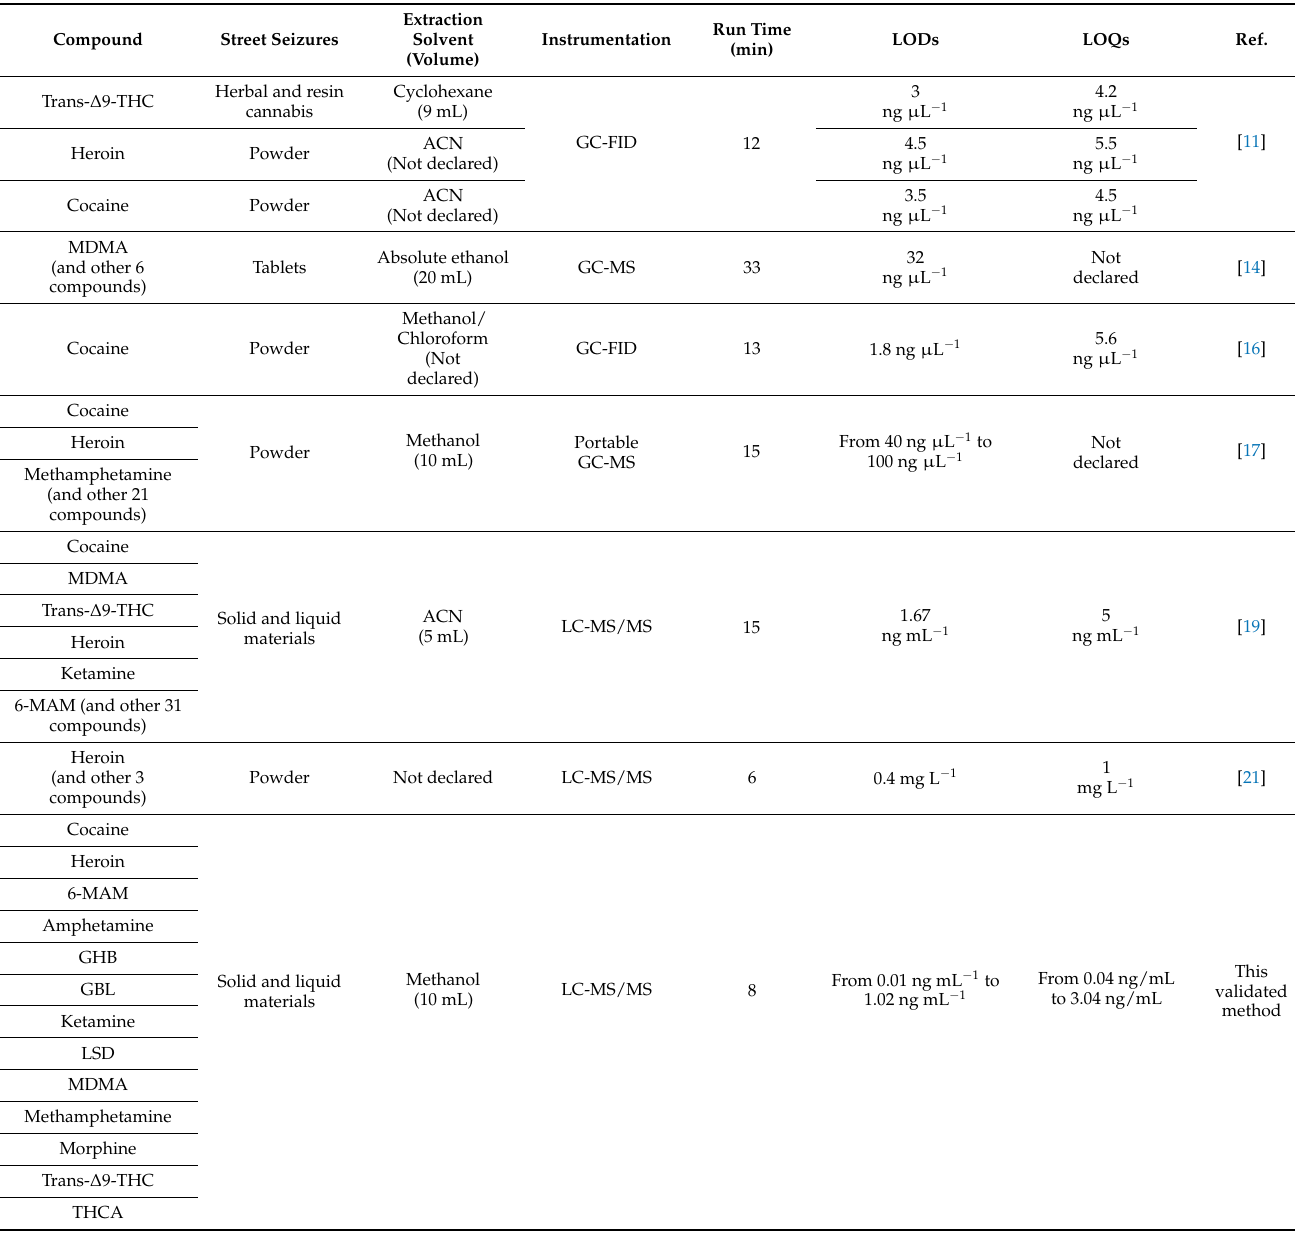
Table 2. Comparison with other methods reported in the